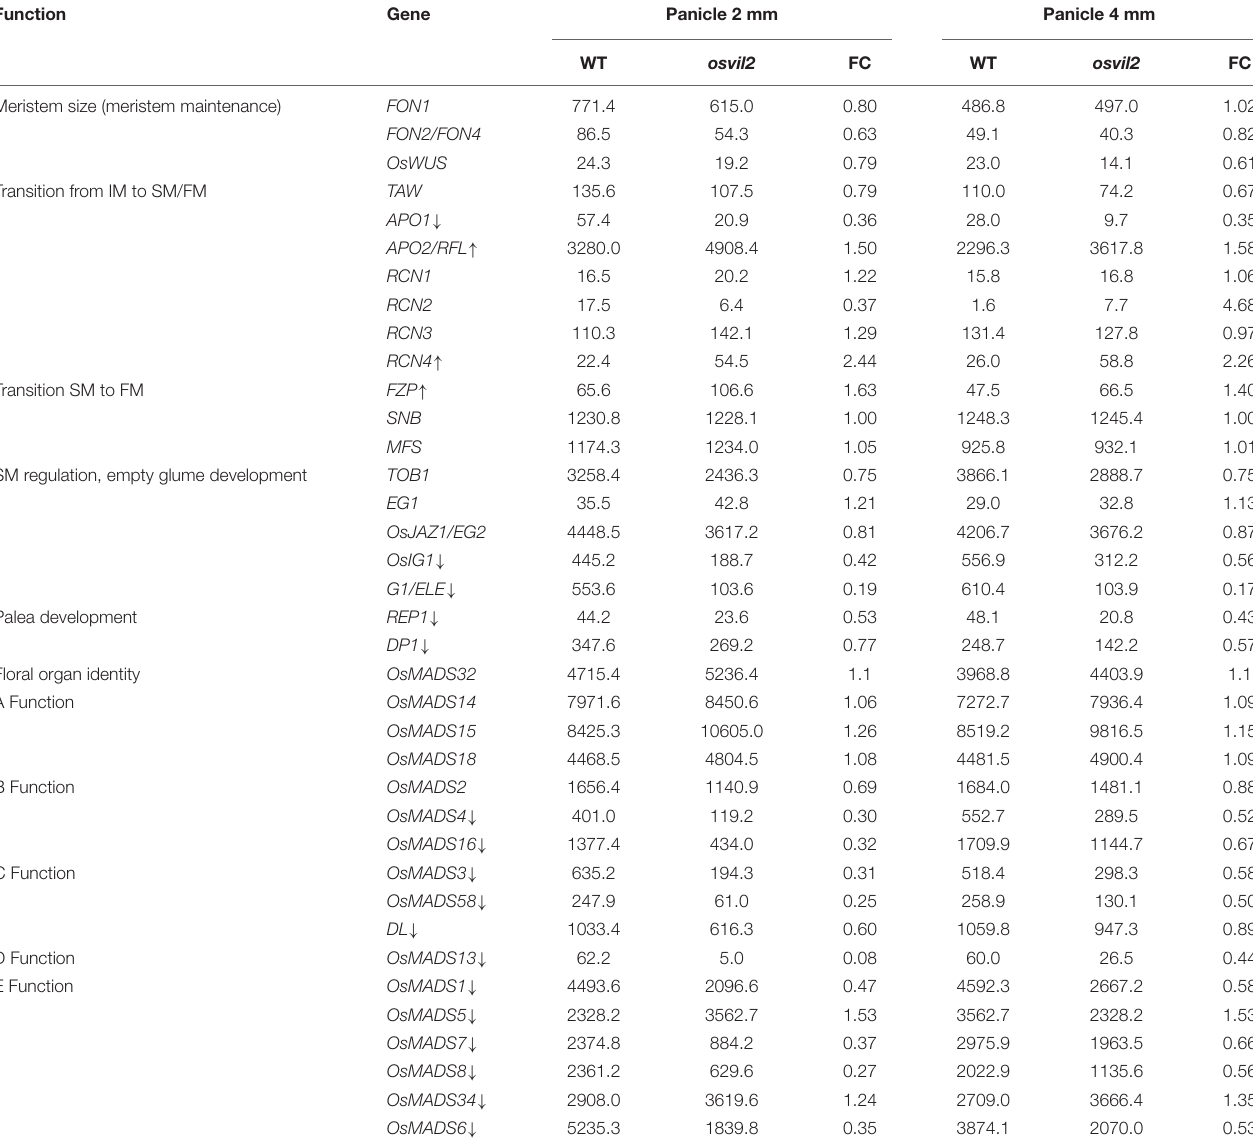
TABLE 1 | Expression levels for genes that control spikelet development.